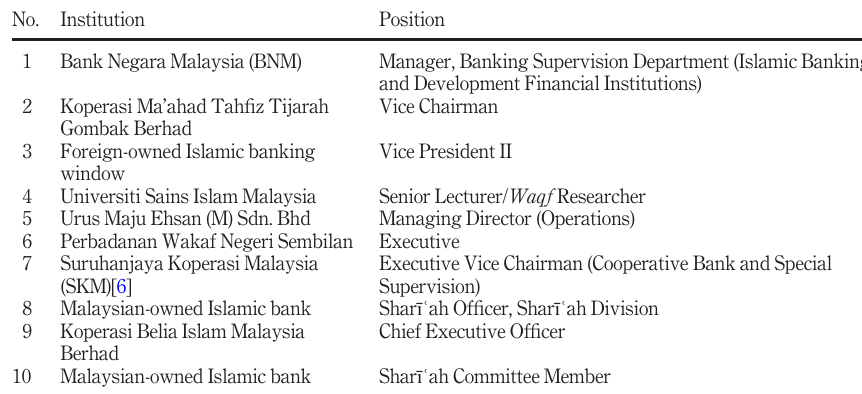
Table I. Pro fi le of the